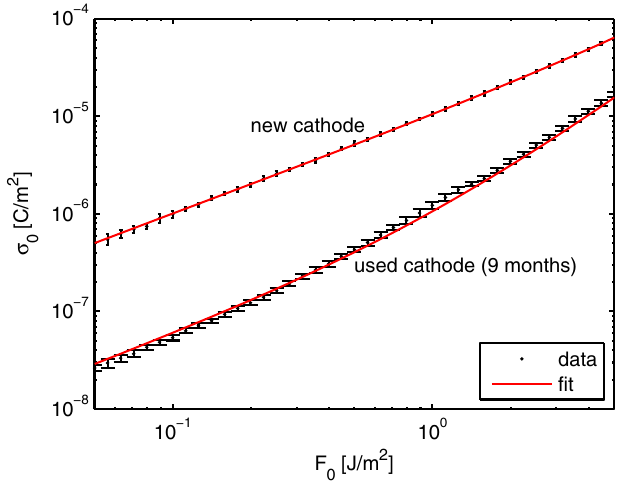
FIG. 6. Measured photoemitted yield at an acceleration voltage of 100 kV for the new and used cathodes.